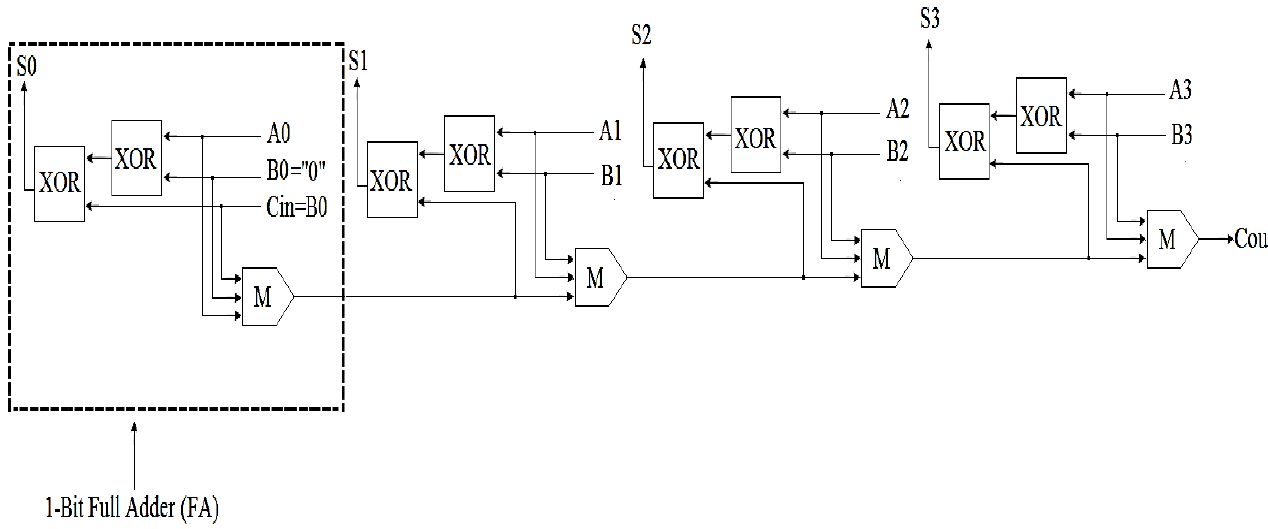
Figure 7. Logical diagram of the proposed 4-bit RCA circuit.